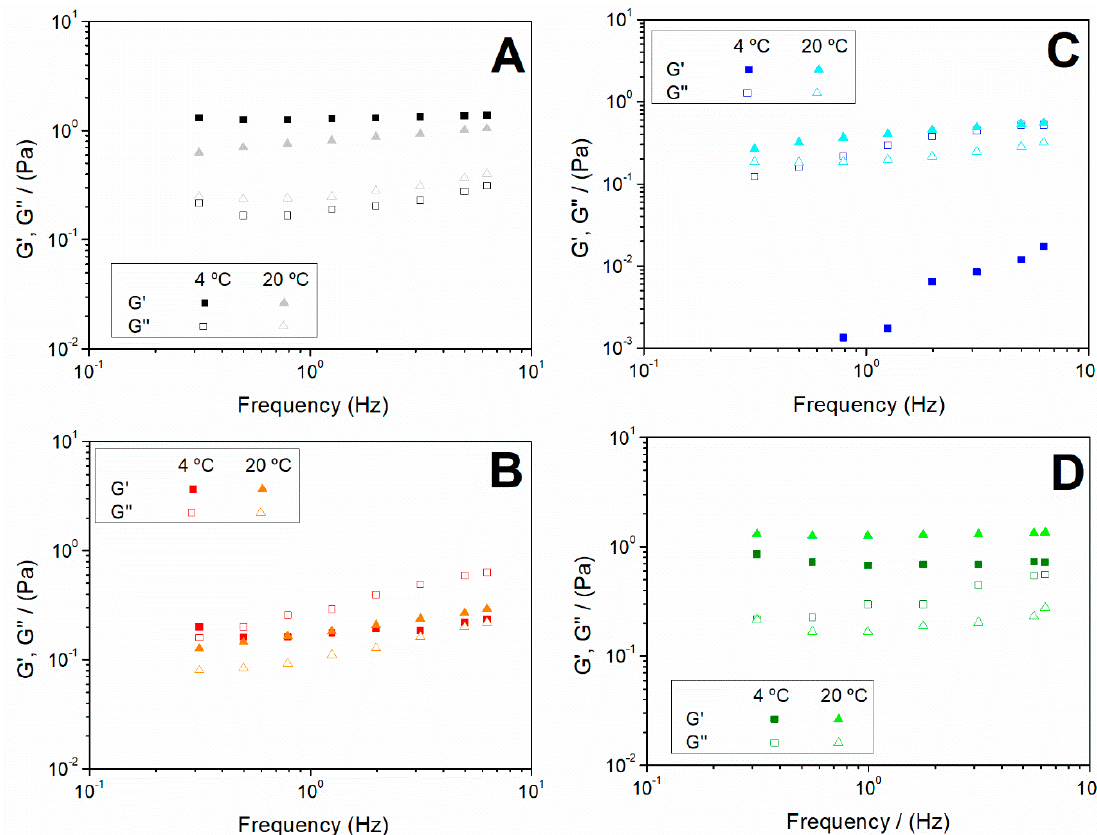
Figure 4. Frequency sweep tests of the hydrogels obtained at 4 and 20 °C and different pH values: ( A ) pH = 3; ( B ) pH = 5; ( C ) pH = 6.5 and ( D ) pH = 10.